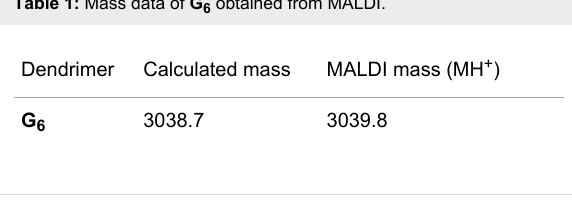
Table 1: Mass data of G 6 obtained from MALDI.